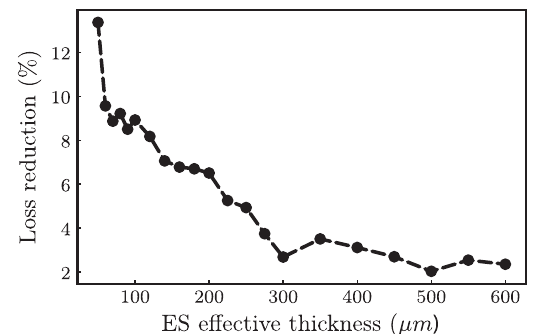
FIG. 3. Simulated loss reduction at SPS ES with dynamic bump as function of electrostatic septum effective thickness in μ